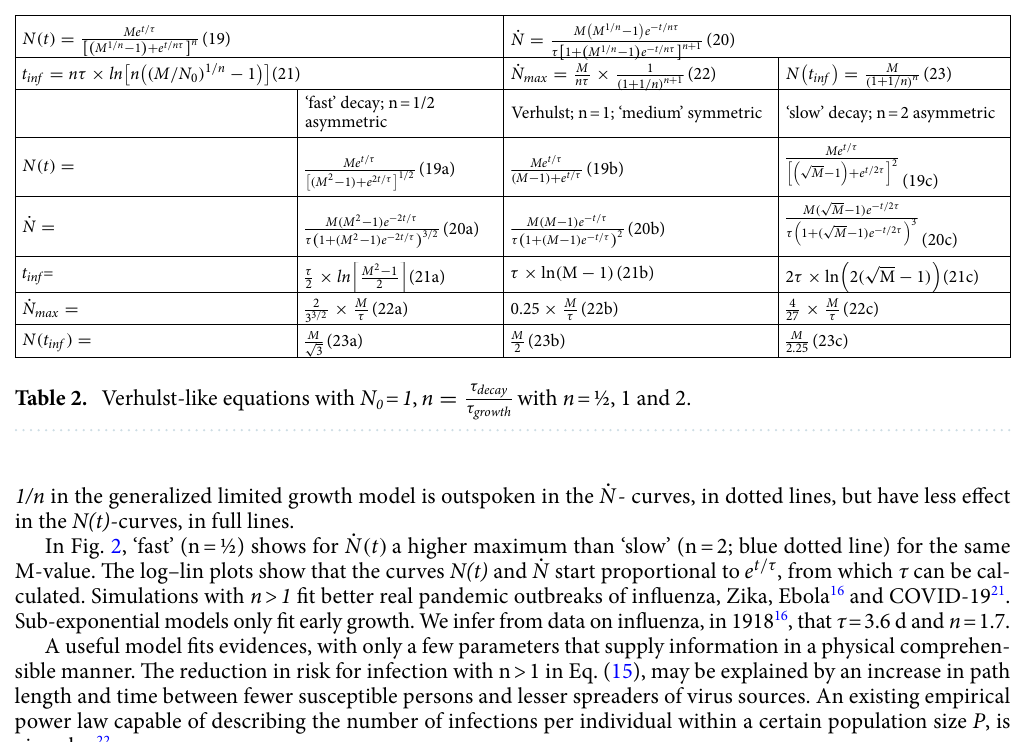
1 in most cases. The indicator, y denotes the number of infections. For many urban indicators β > 1 . with β = In biology, the value β = ¾ was often proposed wrongly as a universal constant. The pace of live decreases with increasing mass 23 . In biology a broad spectrum of phenomena scale over an immense range of mass with β < 1 . The merits of log–lin plots: the slope of the tangent line in ln N(t) vs lin t is the risk Testing the quality of noisy data and validating a hypothesis is easier from a log–lin plot, of N ( t ) and ˙ N , rather than from a lin–lin plot 24 . A straight line in a log–lin plot means an exponential growth, which means a constant relative change per time interval (percentage change). Comparing countries in a pandemic, makes more sense in log–lin plots of N ( t ) and ˙ N ( t ) , rather than in lin–lin plots. Steep slopes are a warning. Inferring from a log–lin plot, the parameter τ is simple. The risk of infection for susceptible per number infected is given by 24 :